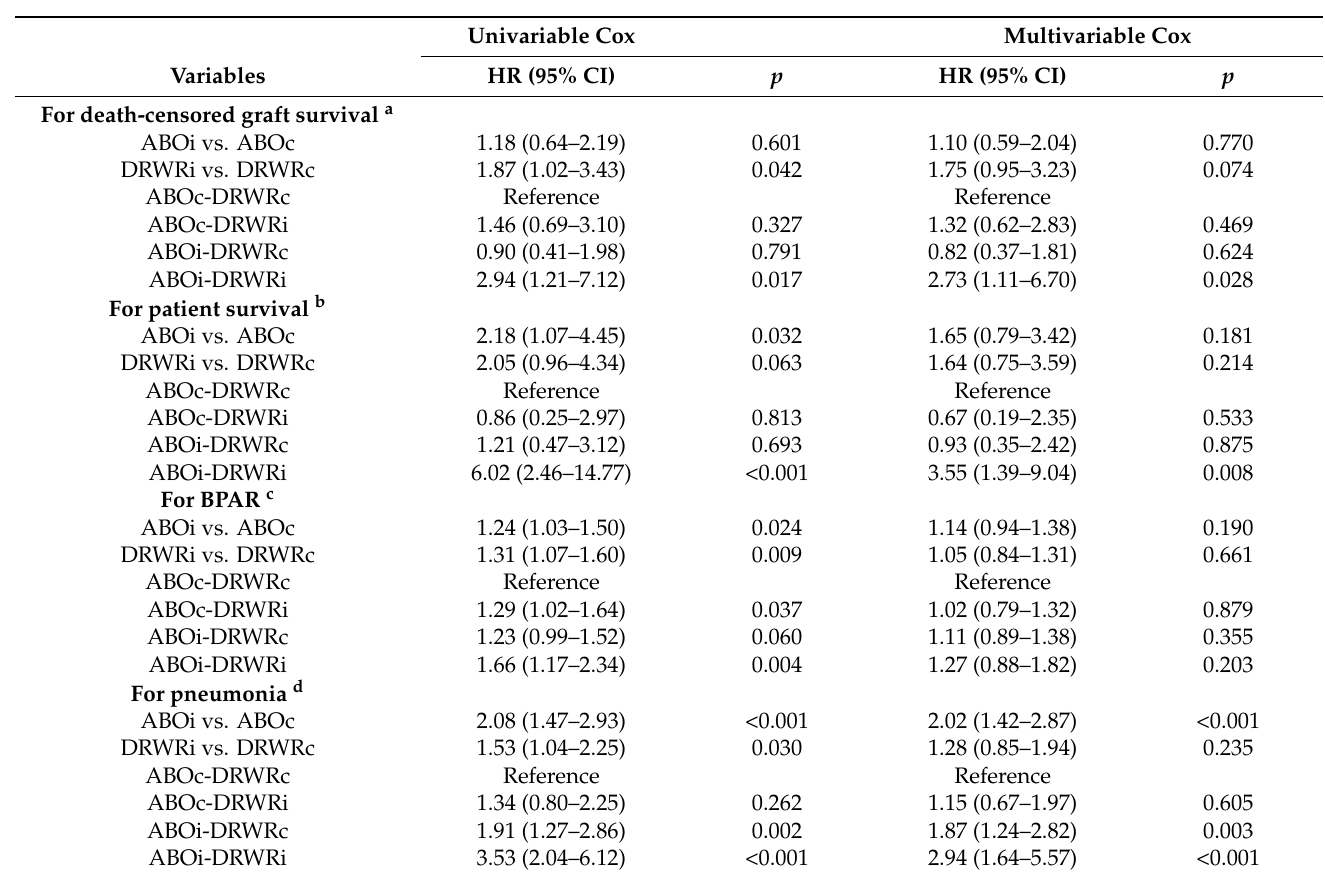
Table 2. Univariable and multivariable Cox